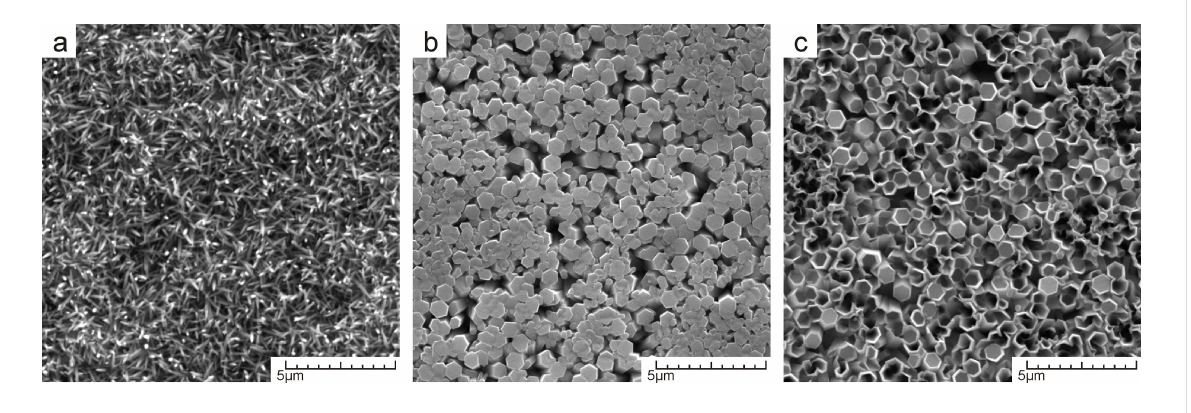
Figure 2: SEM images of as-synthesized ZnO nanostructure arrays: a) nanoneedles, b) nanorods [15], c) nanotubes [15].